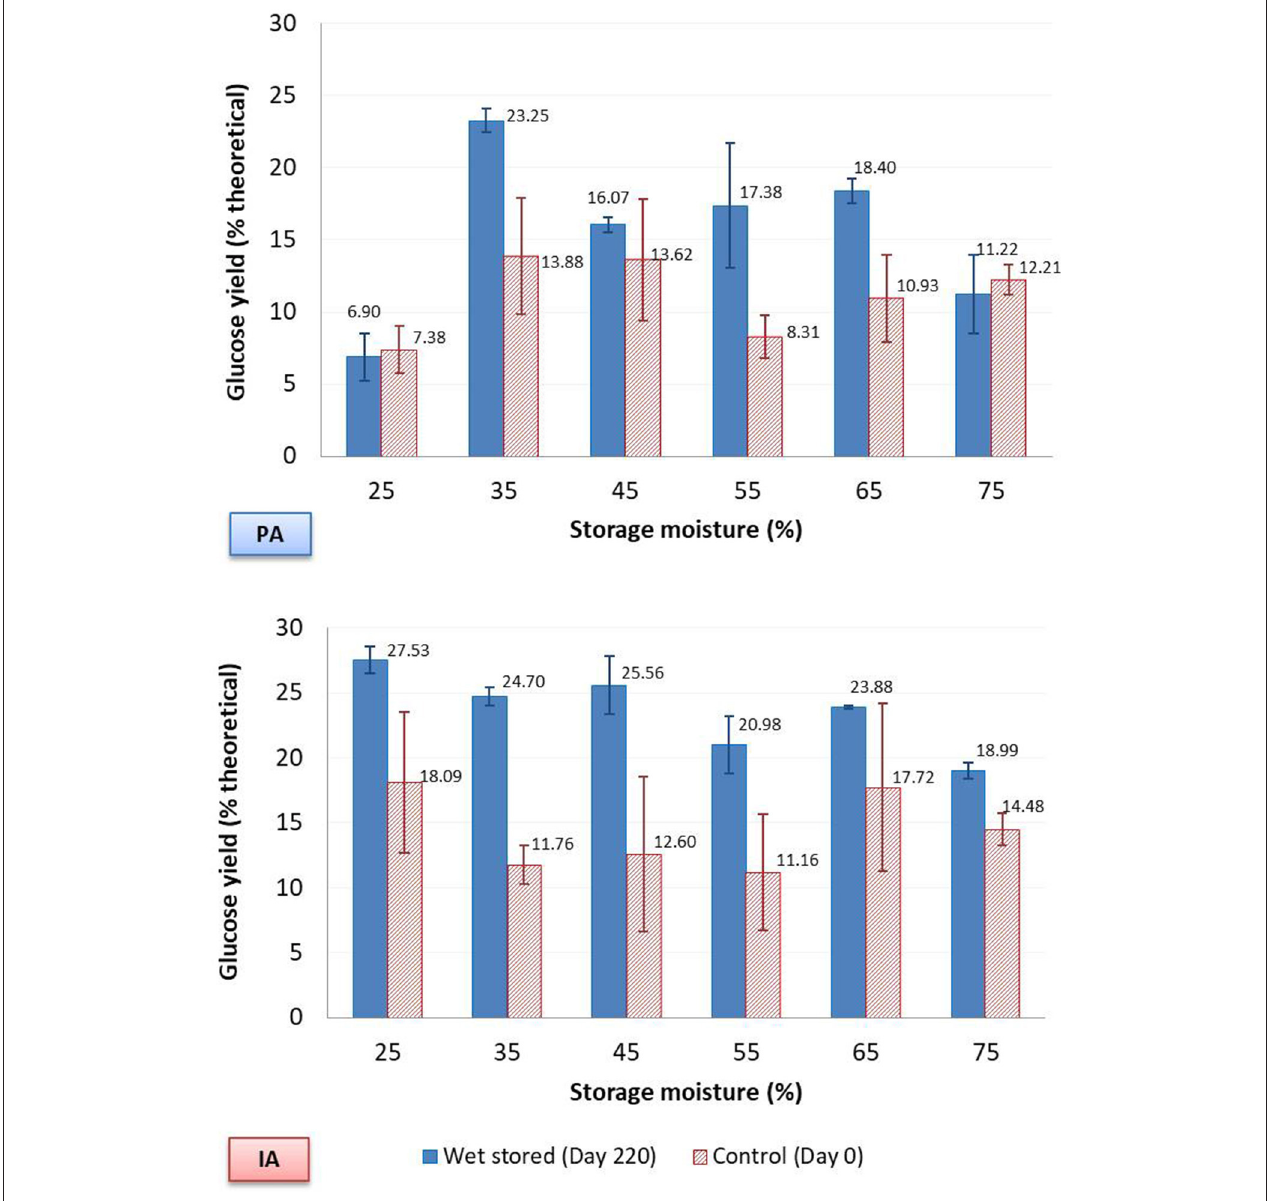
FIGURE 5 | Glucose yield of fiber reactivity test, with 15 FPU/g glucan cellulase enzyme loading, without pretreatment. Error bars are standard deviations of mean.